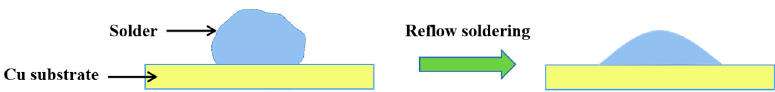
Figure 1. Schematic diagram of Sn35Bi0.3Ag–xIn alloy solder wettability on a copper substrate.